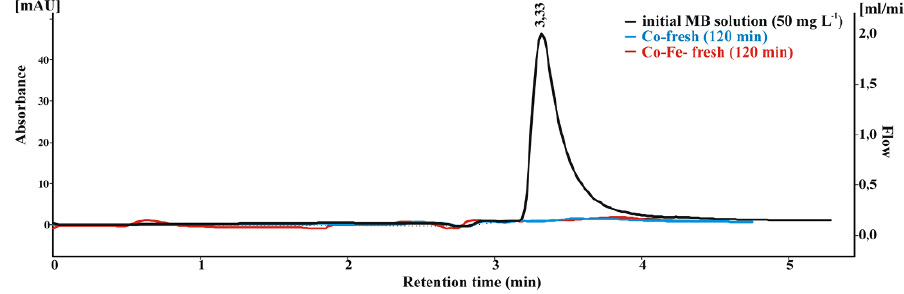
Figure 7. HPLC chromatograms of MB (50 mg L -1 ) before and after catalytic oxidation over Co-fresh and Co-Fe-fresh catalysts.